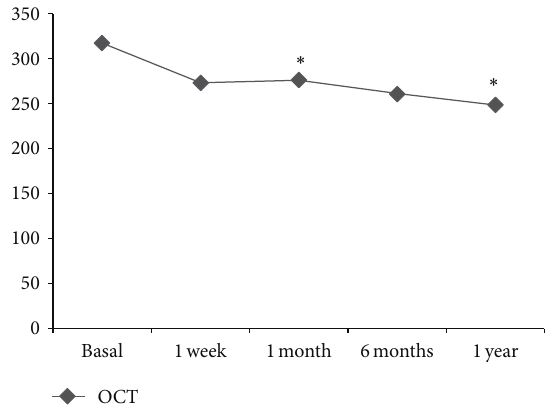
Figure 1: Rapid and maintained improvement of macular thickness (1mm central retinal thickness, macular cube strategy 512×128 , and Cirrus-HDOCT)followingtheonsetofGolimumab(dataexpressed as mean values compared with basal